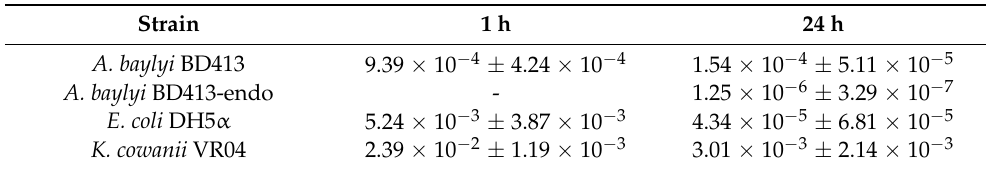
Table 1. The ratio between survived and administered cells of the strains A. baylyi BD413, E. coli DH5 α , and K. cowanii